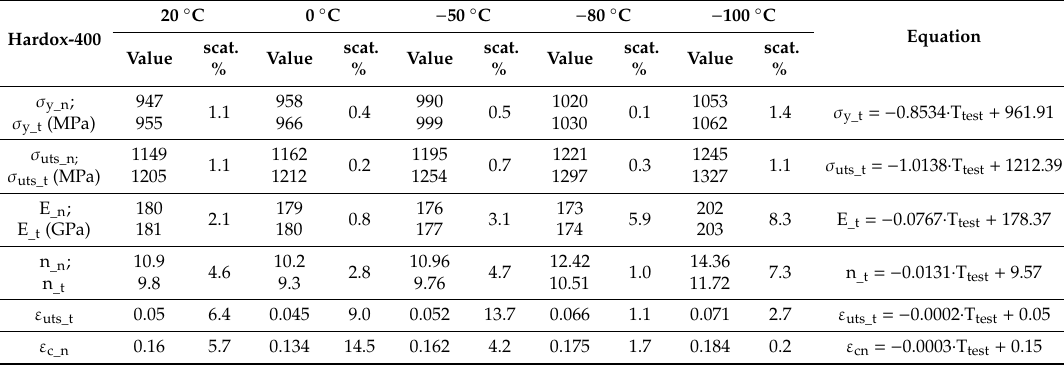
Figure 4. The diagrams of σ – ε for the Hardox-400 steel: ( a ) Nominal and ( b ) true. Table 2. The strength and plasticity properties of Hardox-400 steel.